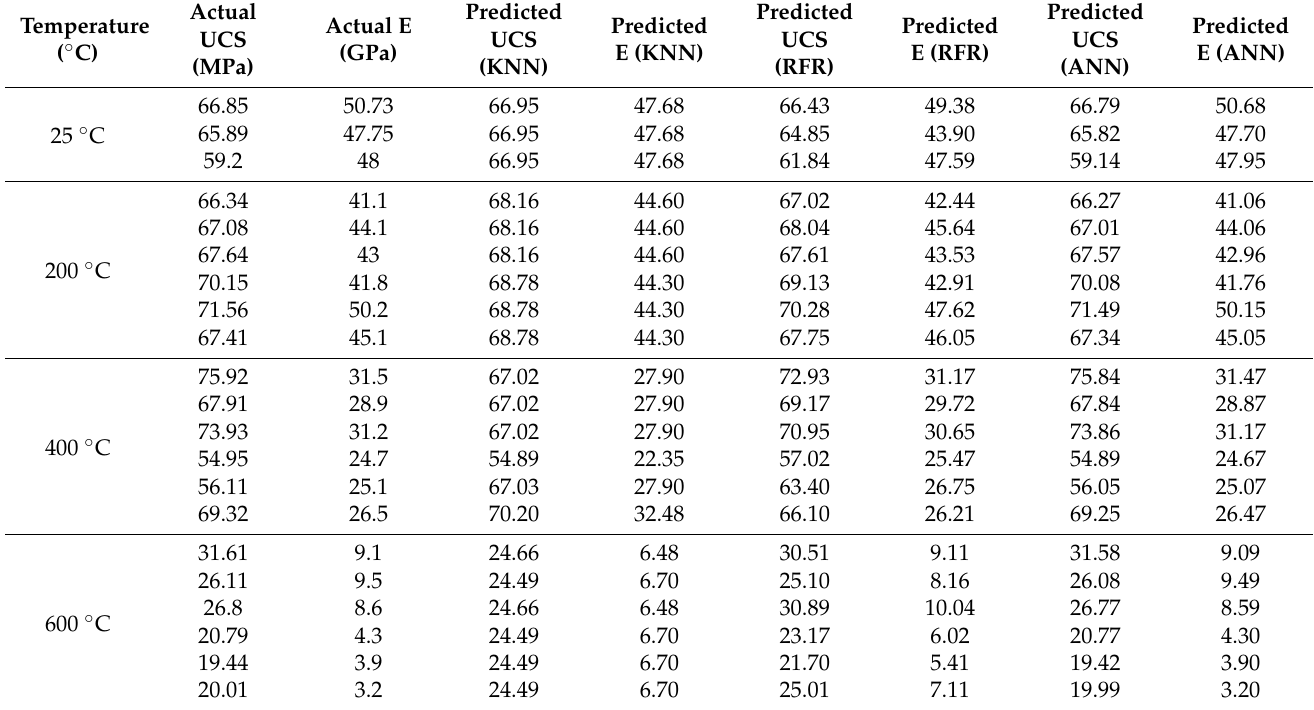
Figure 12. ANN Performance based on the mean squared error metric.